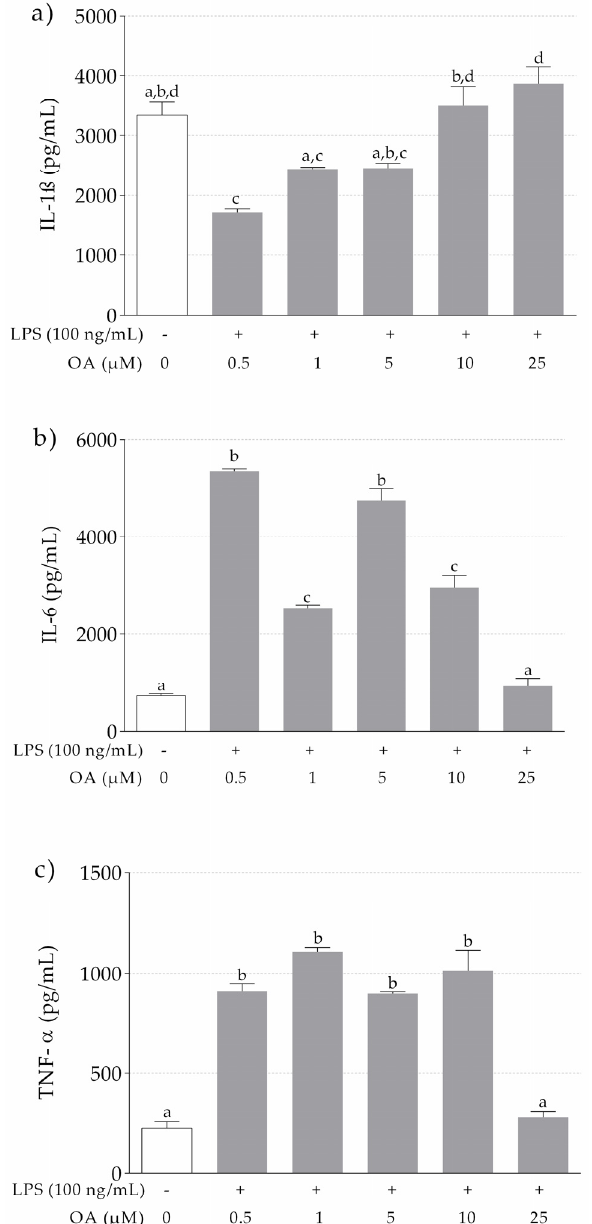
Figure 1. Effects of OA on proinflammatory cytokines production by THP-1 macrophages induced by LPS. Control cells were incubated with DMSO. Experiments performed in triplicate. ( a ) IL-1 β ; ( b ) IL-6; ( c ) TNF- α . Different letters indicate significant difference ( p < 0.05) by one-way ANOVA analysis and Tukey’s post hoc test.